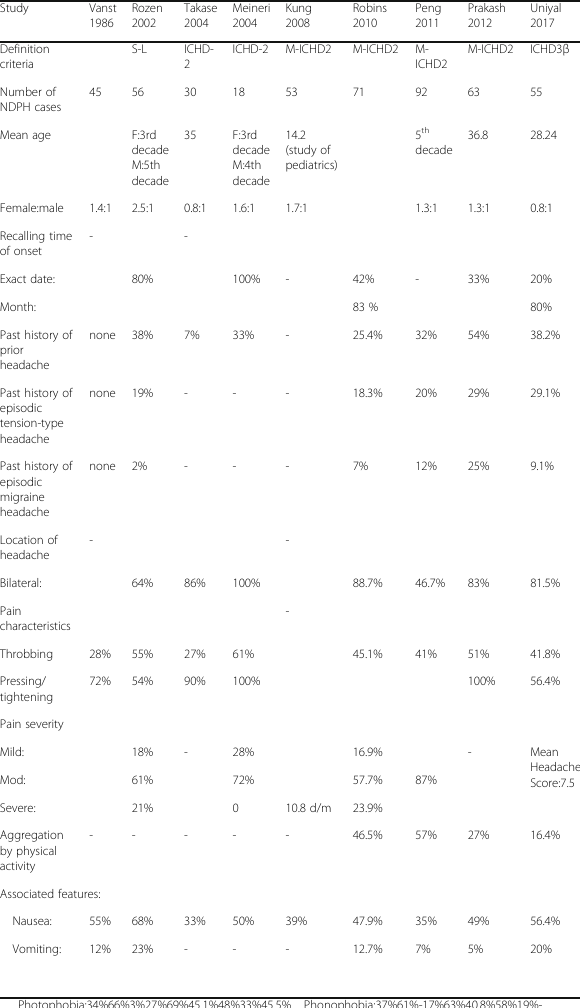
Table 3 (abstract P116). Clinical characteristics of patients with NDPH in various published studies.